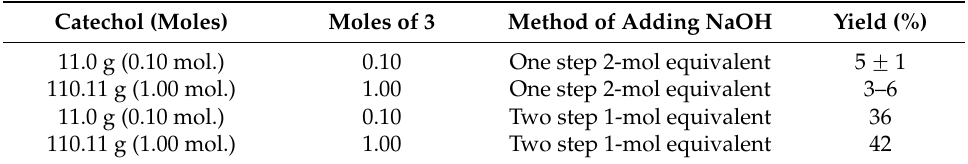
Table 1. Comparison of the reaction amounts and the respective yields of the azacrown according to two